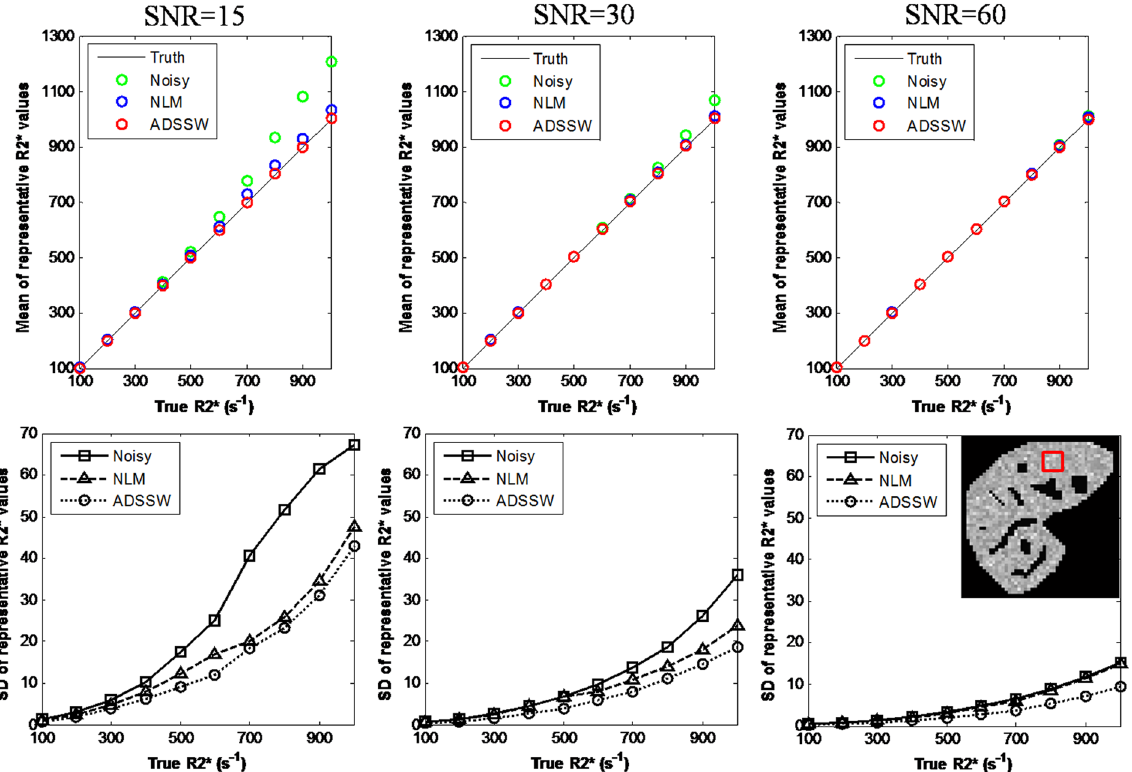
Figure 4. Plot of the means (top row) and SDs (bottom row) of representative R2 * values from 200 repeats against the true R2 * values at varying noise levels (SNR = 15, 30, 60).